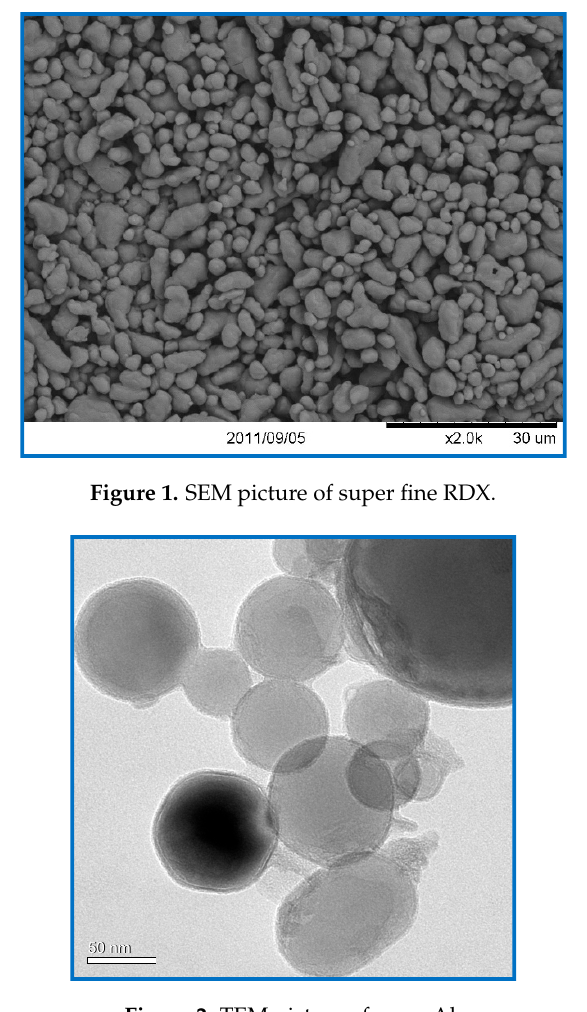
Figure 2. TEM picture of nano-Al.